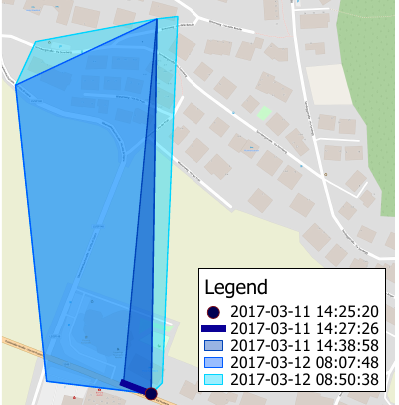
Figure 18. Evolution of the coverage of a cell as new measurements are added to the database over time. A brighter color denotes a more recent state.